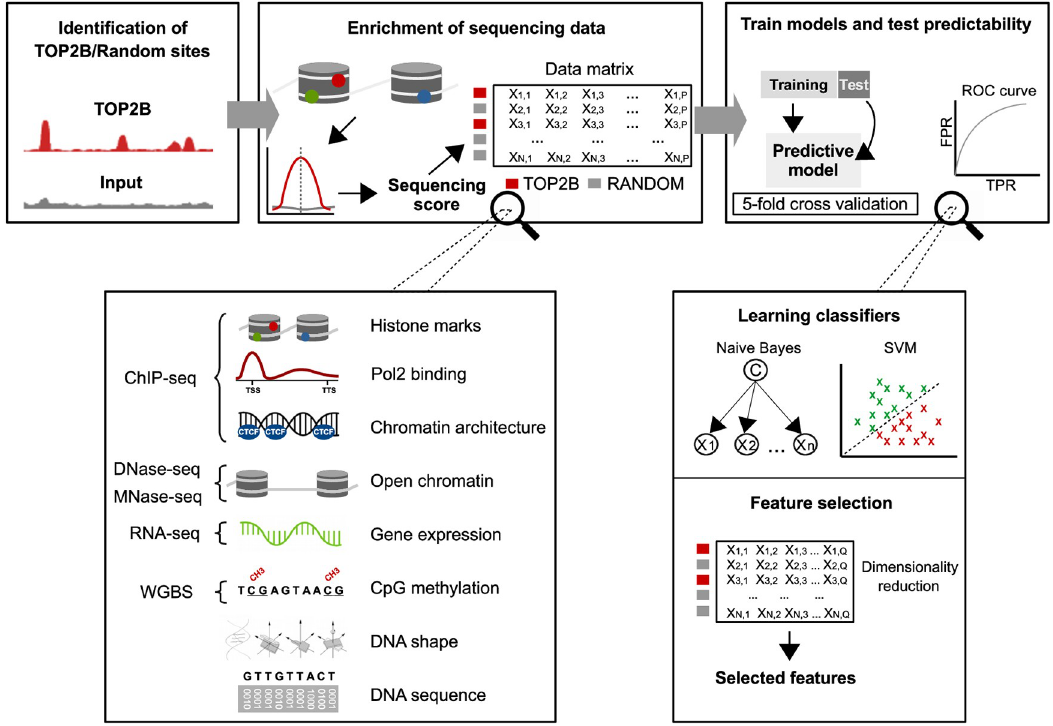
Fig 2. Machine learning schema for the prediction of TOP2B binding. TOP2B binding sites and random regions were first identified. Then, 15 high-throughput sequencing experiments together with DNA sequence and shape features were scored around such regions, which resulted a data matrix with rows representing TOP2B/random sites and columns representing the scored features. Finally, binary classifiers were trained and tested using 5 fold cross-validation and feature selection was applied to identify the most informative